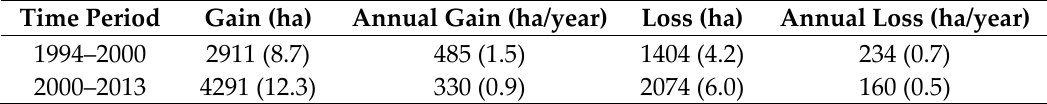
Table 4. Gain and loss of mangrove area (ha) measured for 1994–2000 and 2000–2013 using Landsat data, the proportional change (%) is shown in parentheses.